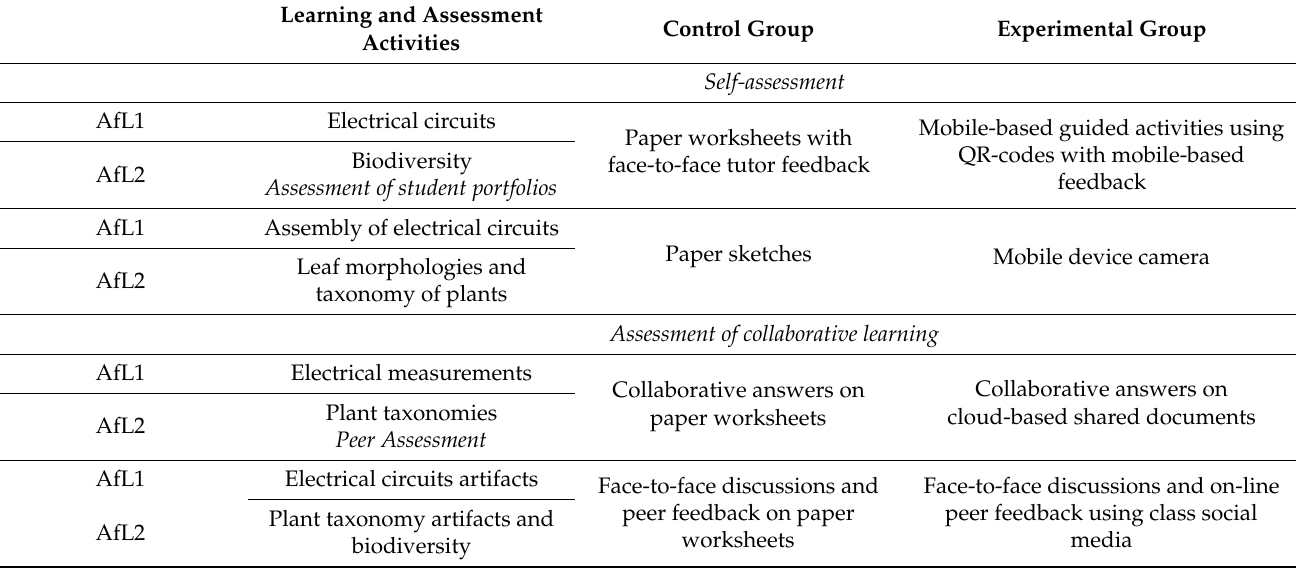
Table 1. Assessment for learning (formative assessment) tasks (AfL1 in the Physics Lab and AfL2 in the Botanic Gardens). Learning and Assessment